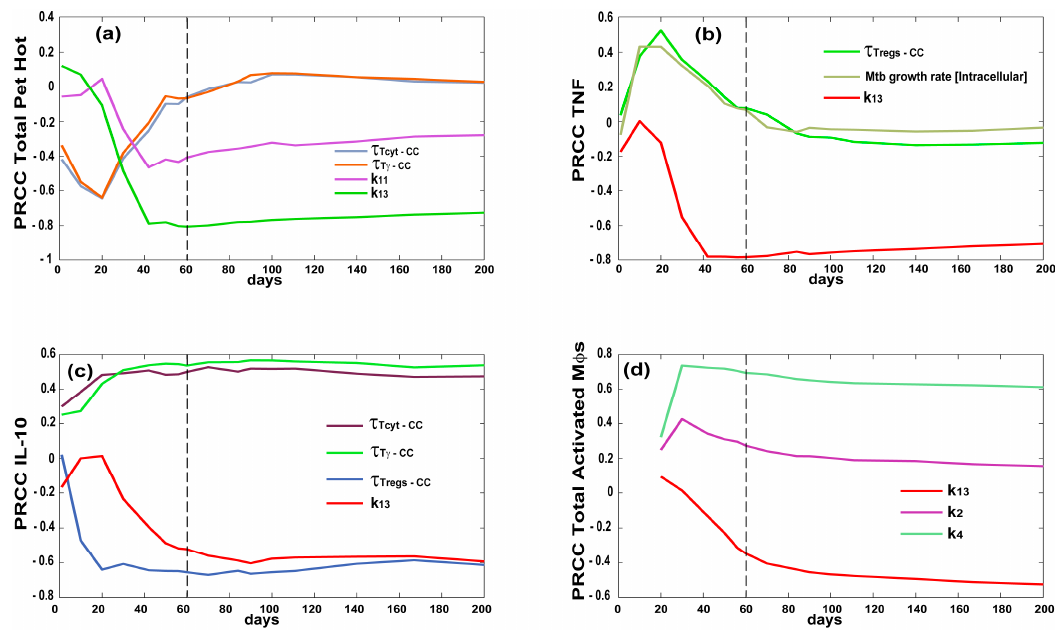
Figure 6. Partial Ranked Correlation Coefficient (PRCC) time courses of mechanisms/parameters affecting inflammation outcomes. Each plot has days post infection (up to 200 days) on the x -axis and PRCC values on the y -axis (between − 1 and 1). The PRCCs plotted are the only ones that resulted significant (i.e., p < 10 − 3 ) and with an absolute value greater than 0.3. Outcomes shown are ( a ) total Pet Hot, ( b ) TNF, ( c ) IL-10 and ( d ) total activated macrophages. Parameter definitions: